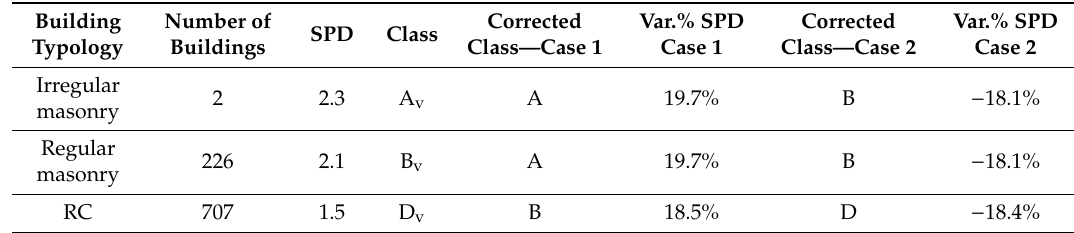
Table 11. Synthetic parameter of damage (SPD) indexes and vulnerability classes for masonry and reinforced concrete (RC) buildings according to the SAVE method (935